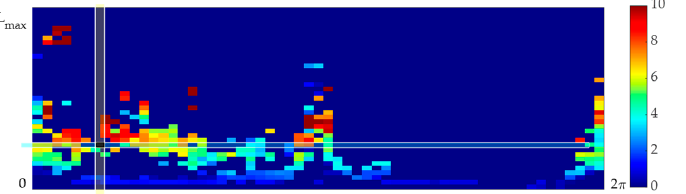
( b ) Scan context, with yellow and cyan column representing the same sector and ring in the above, while the bin is in black. Figure 6. Visual illustration of a challenging example of scan context. Figure 6. Visual illustration of a challenging example of scan context.